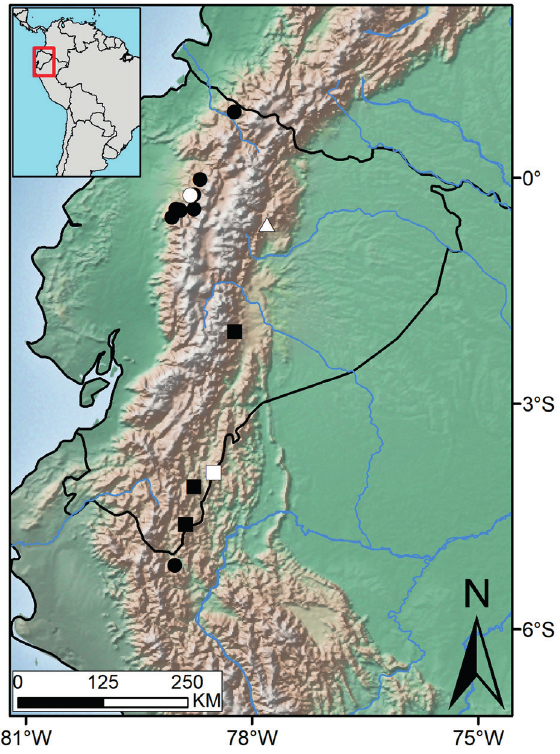
Figure 5 - Known distribution of Atractus atlas (squares), Atractus gigas (dots), and Atractus touzeti (triangles). each type-locality is represented by open symbols. We did not include the new record of A. touzeti provided by Arteaga et al. (2017) because the identification of this specimen was not checked personally by